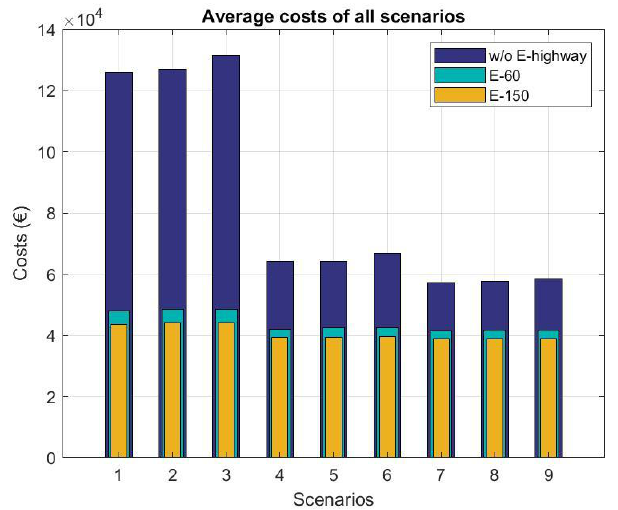
Figure 9. Average costs for all trucks of all scenarios (own illustration).